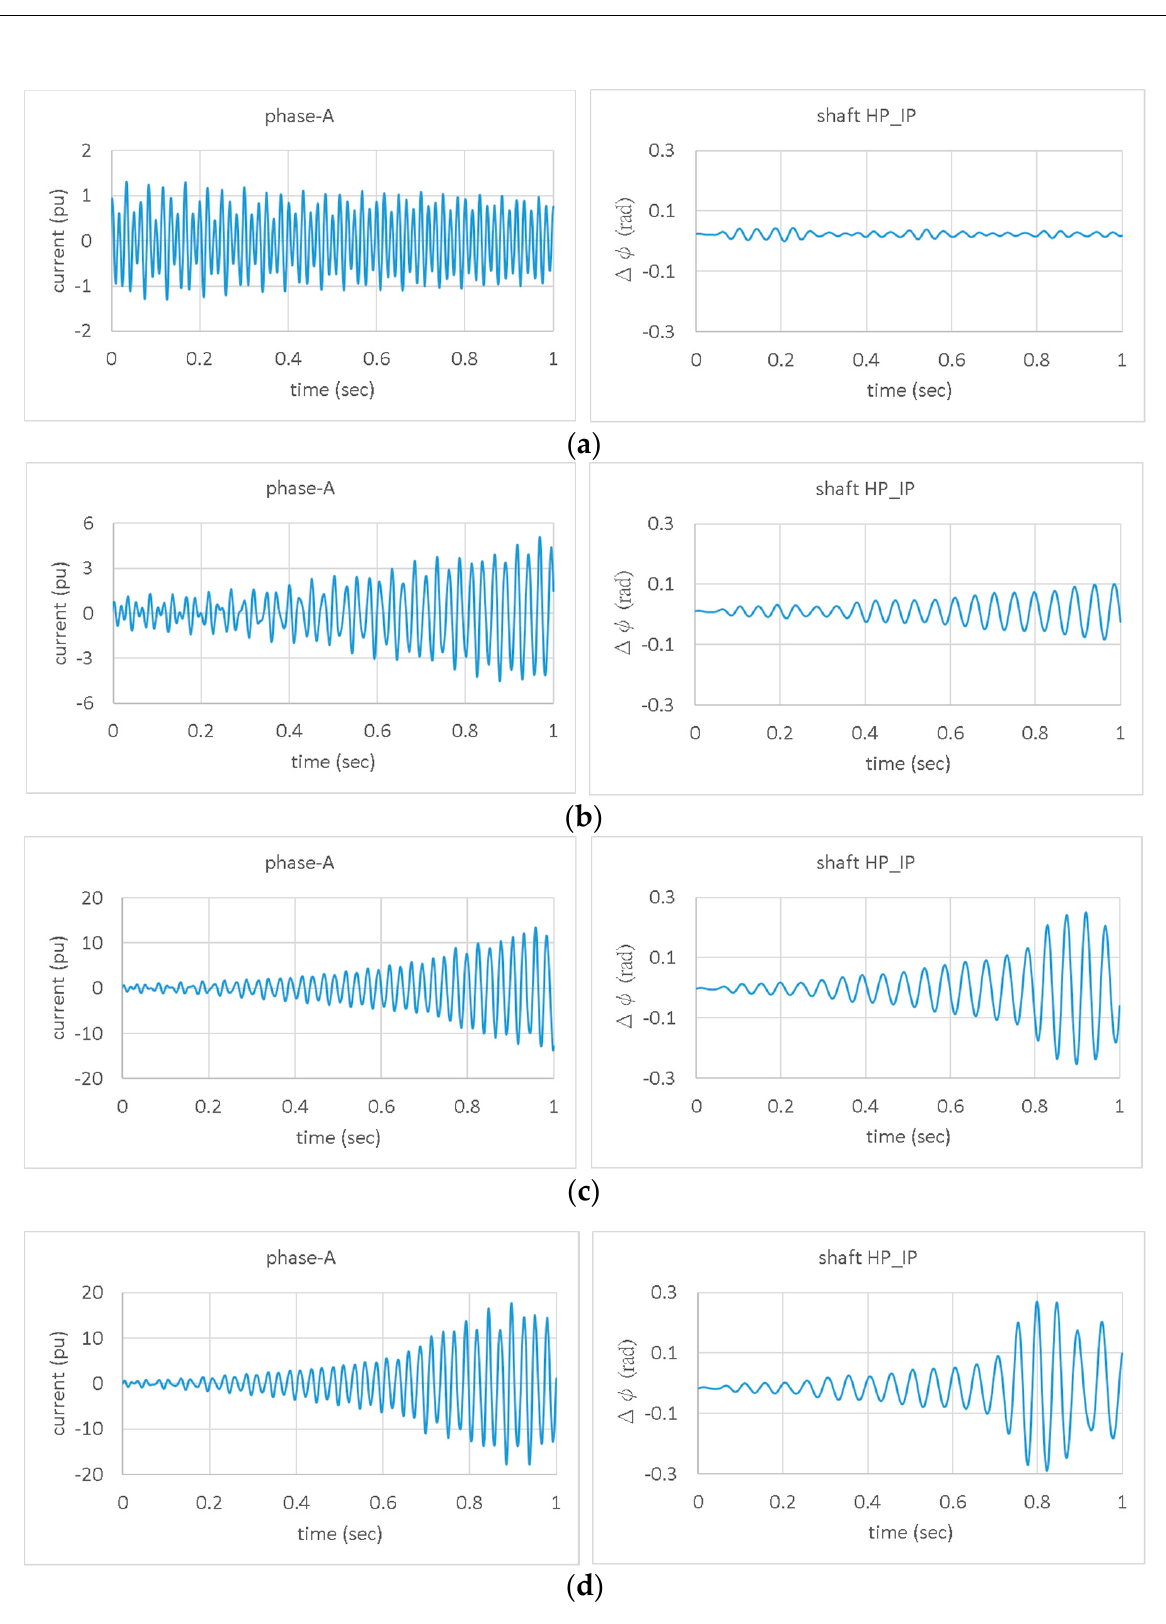
Figure 9. Generator currents and torsional vibrations for different penetration rates of DFIG wind power, ( a ) 12.5%, ( b ) 37.5%, ( c ) 62.5%, and ( d ) 87.5%.